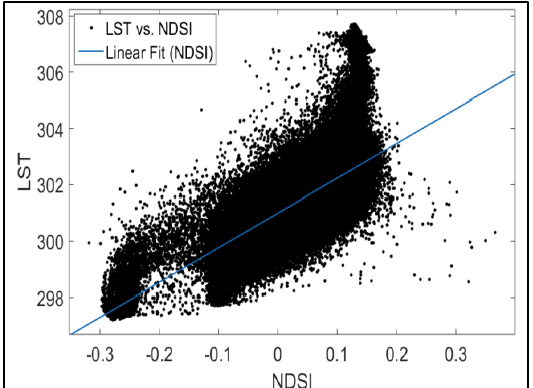
Figure2. LST image of Varanasi